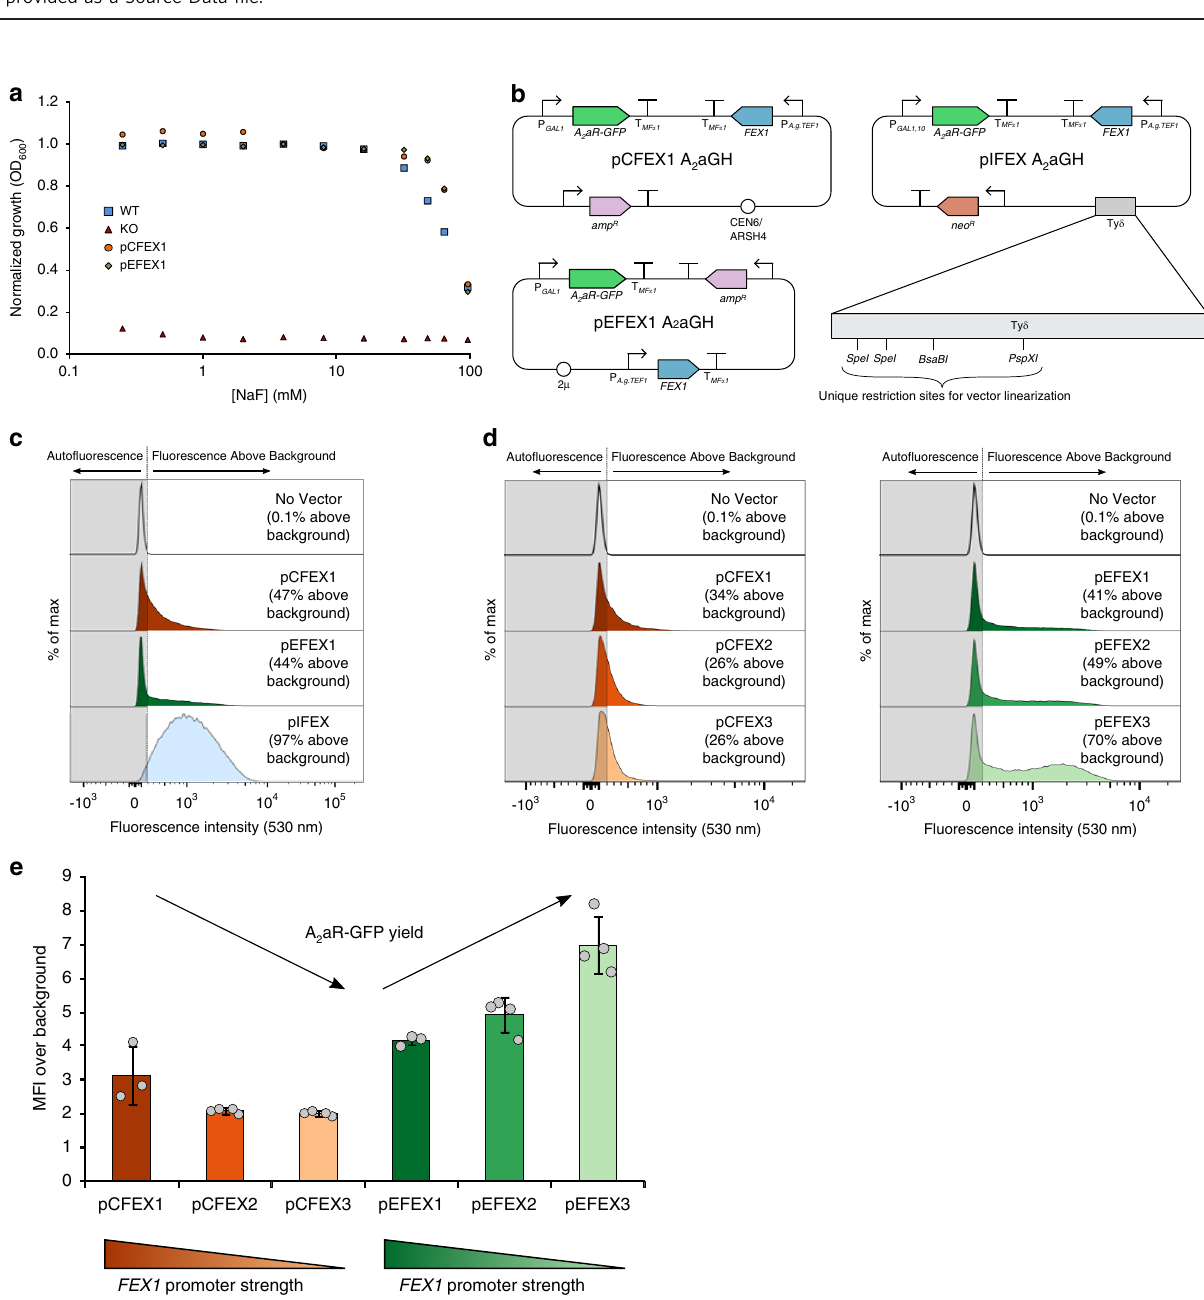
Fig. 2 Yeast strains lacking FEX genes provide a stringent, passive biocontainment mechanism. a A yeast spotting assay demonstrates sensitivity of yeast lacking FEX genes to µ M concentrations of NaF. b Dose response curve of the biocontainment strain illustrates three orders of magnitude greater sensitivity to fl uoride compared to the parent wildtype strain. c In the absence of fl uoride, growth of the biocontainment and wildtype parent strains in YPD is nearly indistinguishable. d , e Phenotypes of yEGFP production in the biocontainment and wildtype strains are also nearly identical, demonstrating the versatility of the biocontainment strain for engineering without deleterious effects associated with FEX knockouts. f Cell growth is severely inhibited both in the presence of NaF as well as after washing and subculturing into fresh media, albeit to a lesser extent. In b , c , e , and f , data represent the mean of three biological replicates, and error bars represent their standard deviation. The histograms presented in d correspond to representative samples. Source data are provided as a Source Data fi le.